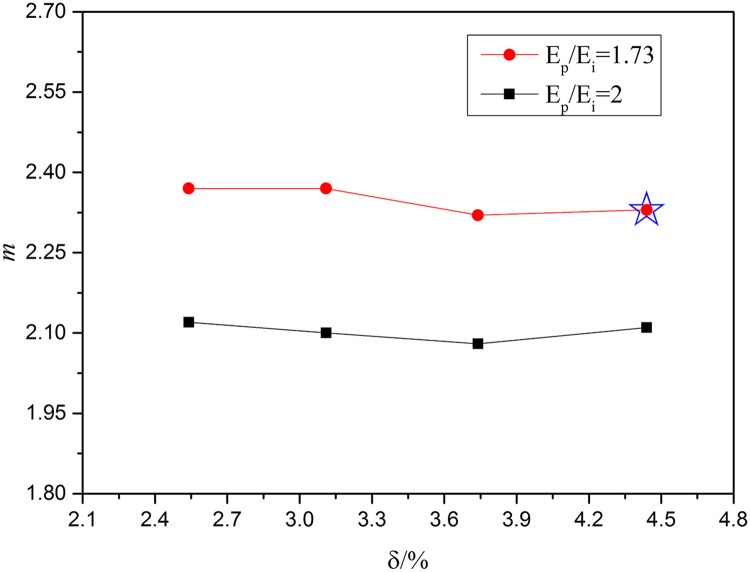
The relationship between porosity, m and Ep/Ei.